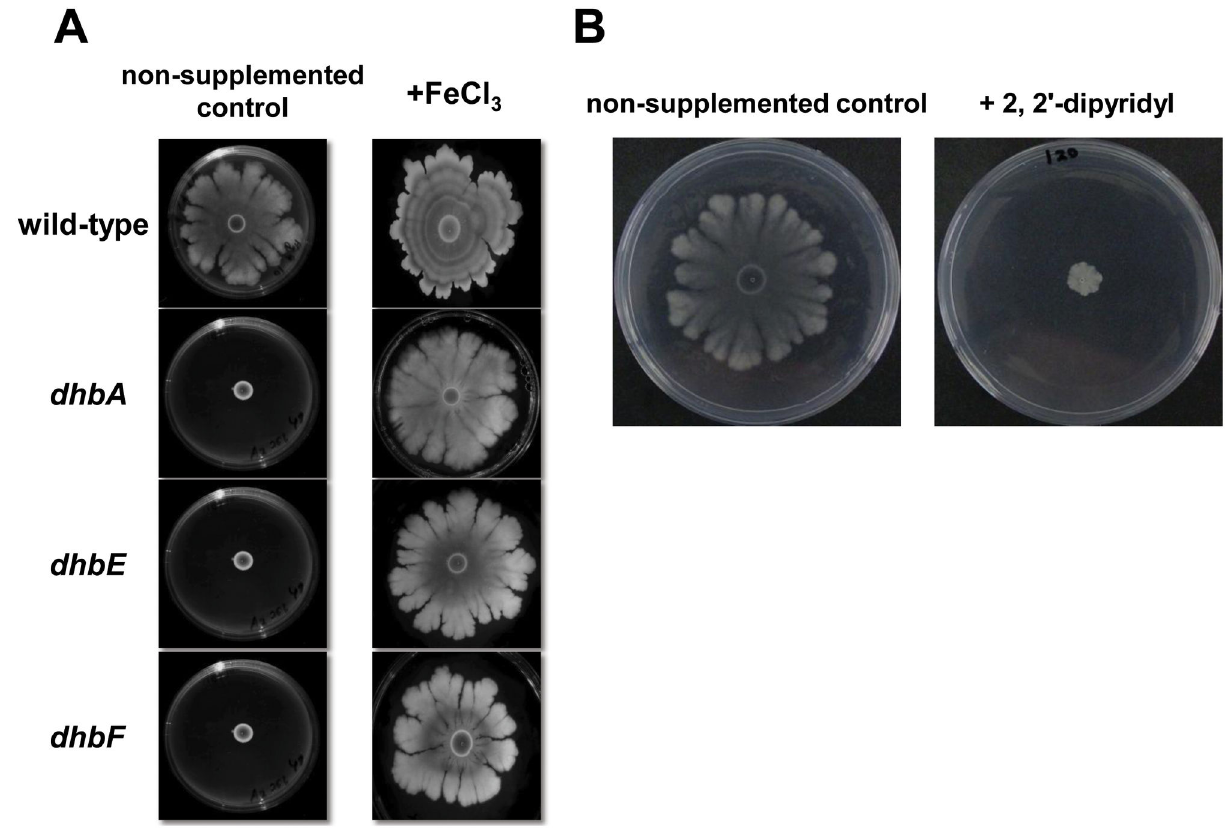
Figure 6. Iron is essential for complex colony development in Bacillus subtilis . A . Three μl of a fresh overnight grown culture were spotted onto the center of spreading plates containing 1.2% agar (left) and spreading plates containing 1.2% agar supplemented with 150 µM Fe +3 (right), and incubated at 37°C in a humid and dark environment. Plates were photographed after 72 hours. B . Three μl of a fresh overnight culture were spotted onto the center of spreading plates containing 1.2% agar (left) and spreading plates containing 1.2% agar supplemented with 120 μM of an iron chelator, 2,2'-dipyridyl (right) and incubated at 37°C in a humid and dark environment. Inhibition of complex colony development in the dhb mutants in the presence of 120 μM 2, 2'- dipyridyl was observed following 72 hours of incubation at 37°C. The presented results are representative of five independent